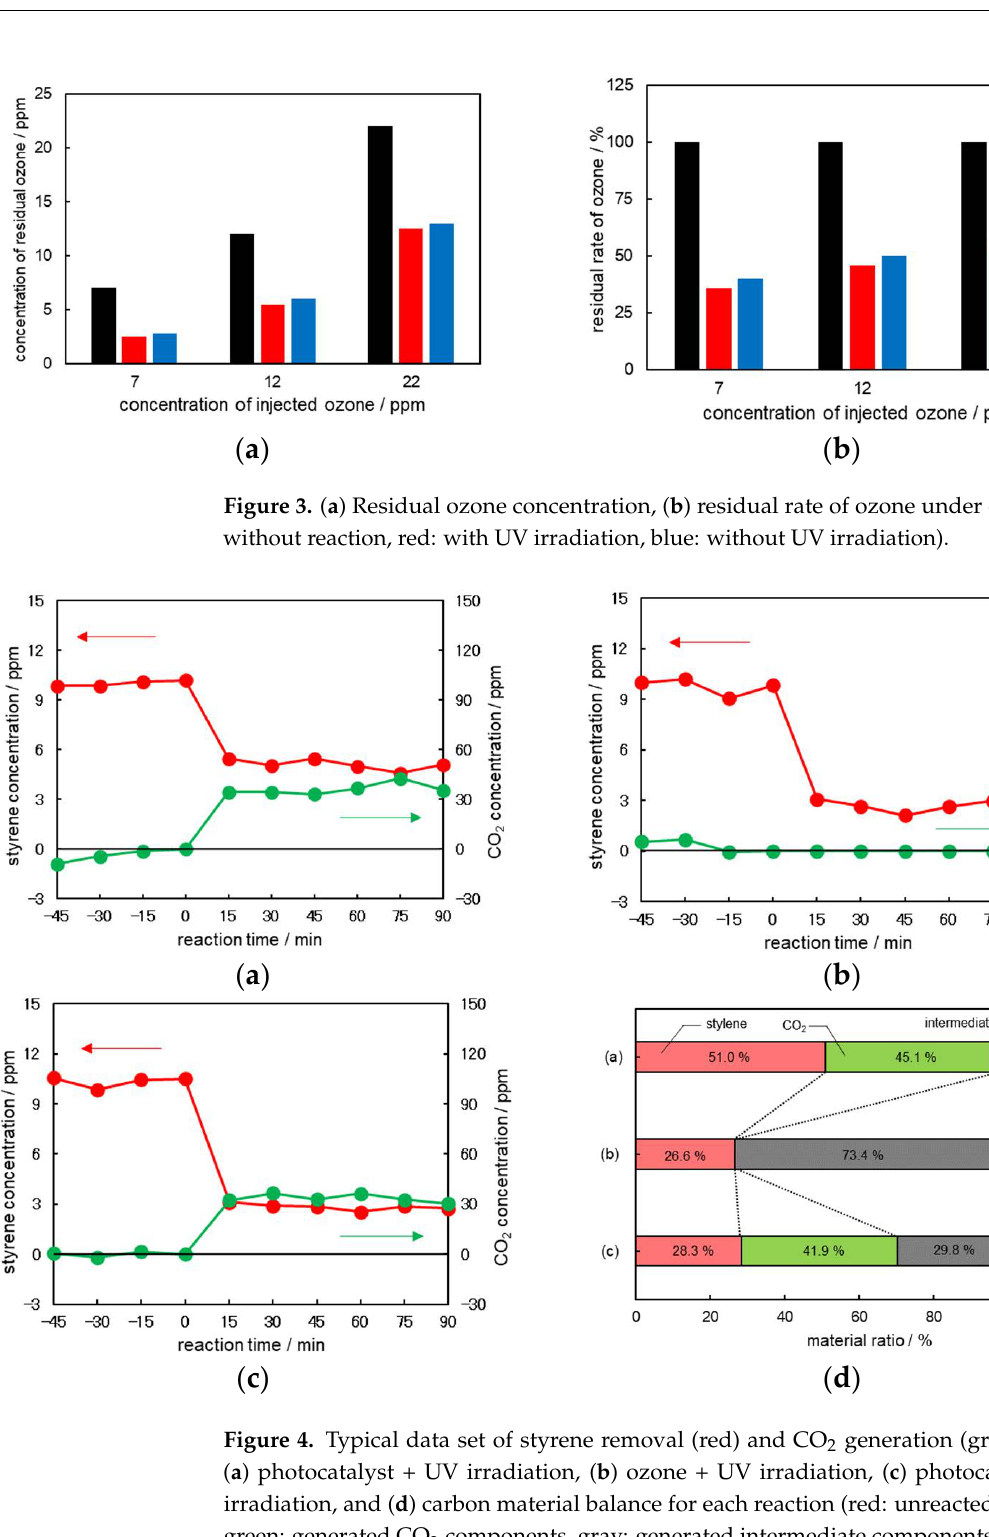
( b ) Figure 1. ( a ) Typical data set of styrene removal by reaction with each ozone concentration (green, red, and orange indicate 7 ppm, 12 ppm, and 22 ppm, respectively). ( b ) Typical data set of styrene removal (red, blue) and CO 2 generation (green, yellow) by reaction with ozone (red, green: with UV irradiation, blue, yellow: without UV irradiation). Figure 2. Gas chromatograms of gas components at reactor outlet by activated carbon tube–solvent extraction method (red: with ozone and UV irradiation, blue: with ozone only). The ozone gas concentration at the reactor outlet was measured using the gas-detec- tion tube method. Figure 3 shows the residual concentration and residual rate of ozone at the reactor outlet for each condition. For all ozone concentrations, ozone was not con-